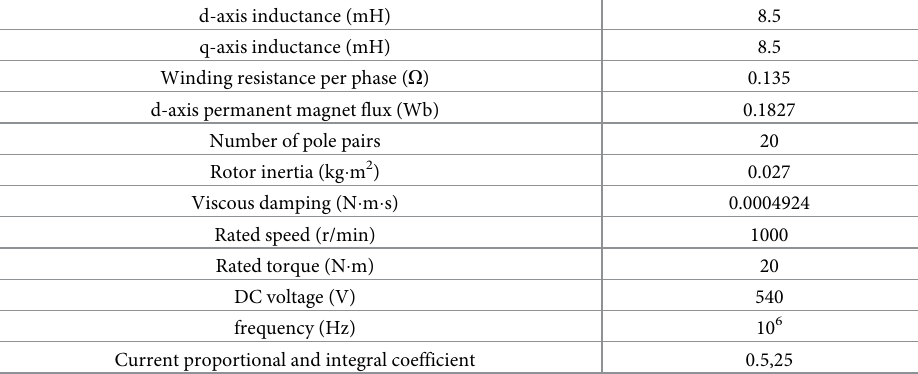
Table 1. Main parameters of PMSM used in the simulation.